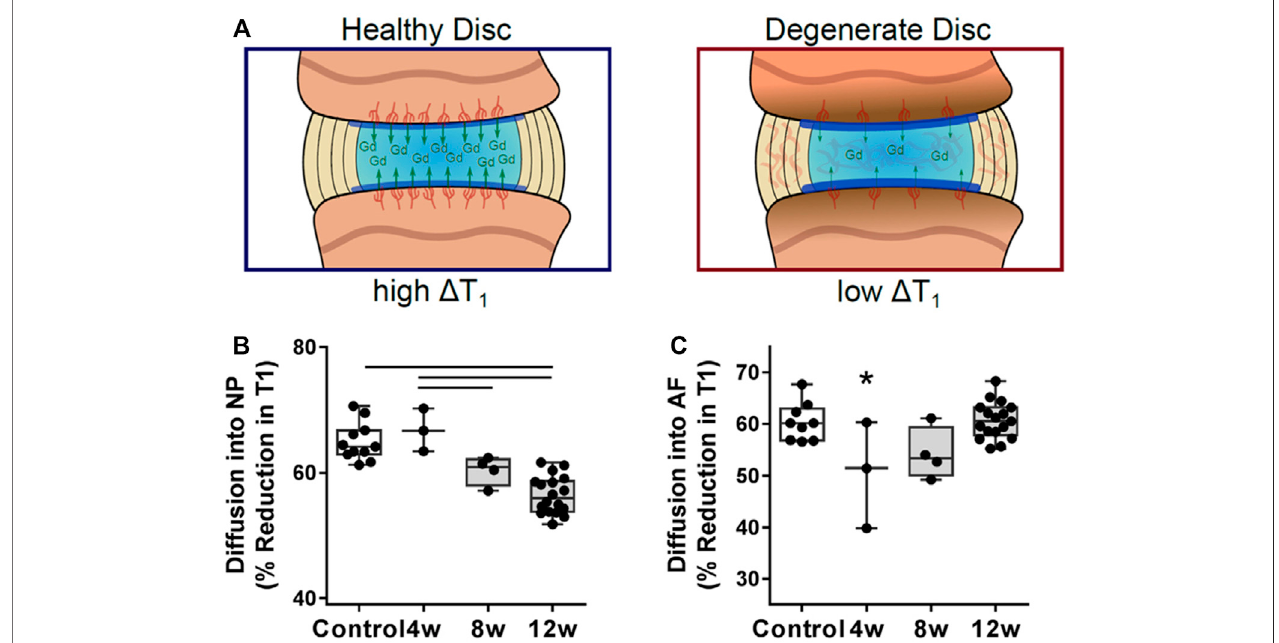
FIGURE 5 | (A) The change in T1 relaxation time within the intervertebral disk after administration of the contrast agent gadodiamide (B) Within the NP, gadodiamide diffusion into the disk progressively decreased and was signi fi cantly lower at 12 weeks compared with healthy controls. (C) Diffusion into the AF was signi fi cantly reduced at 4 weeks post-puncture, followed by a return to control levels. ( (A – C) Adapted from Ashinsky et al.